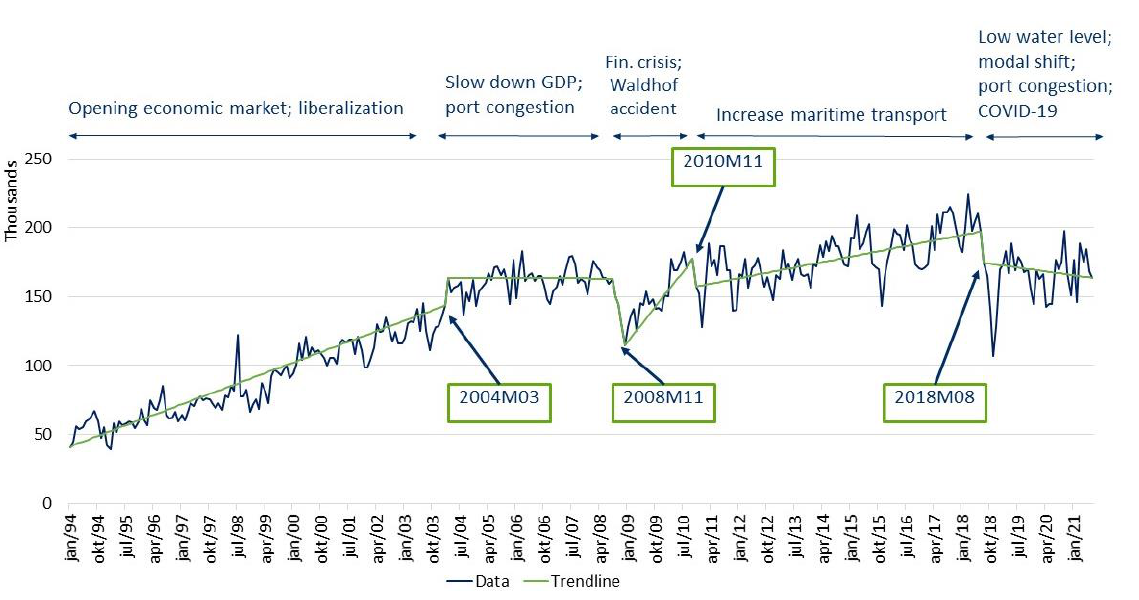
Figure 3. The monthly development of the container transport (TEUs) on the